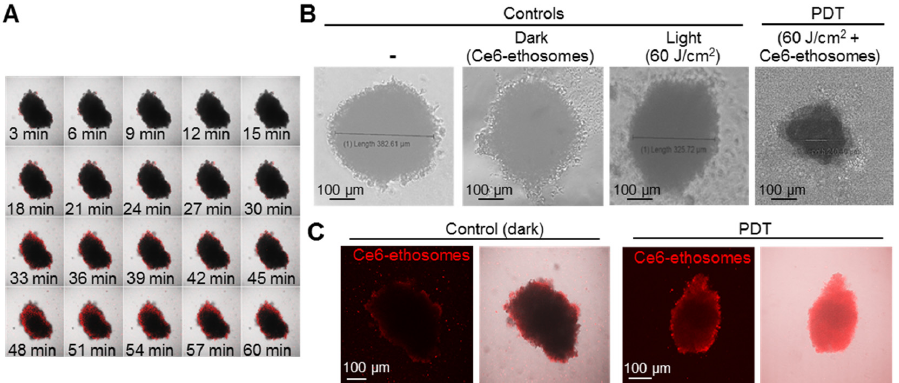
Figure 4. Evaluation of PDT effects of Ce6 ethosomes on human squamous cell carcinoma spheroids. ( A ) Confocal microscopic images of A431 squamous cell carcinoma spheroids treated with 5 µM Ce6 ethosomes (Ex/Em 400/660 nm) for up to 60 min. ( B ) Control (A431 spheroids only), dark control (A431 spheroids treated for 48 h with 5 µM Ce6 ethosomes), and light control (A431 spheroids